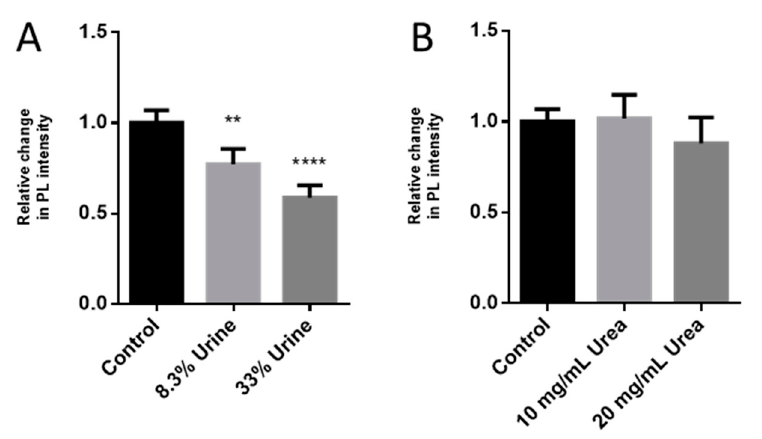
Figure 8. Effect of the urine and urea concentration on the sensors’ PL. Response of the biosensor to addition of ( A ) 8.3% or 33% urine and ( B ) 10 or 20 mg/mL urea. Error bars represent SD. One-way ANOVA, p < 0.05, n = 4.